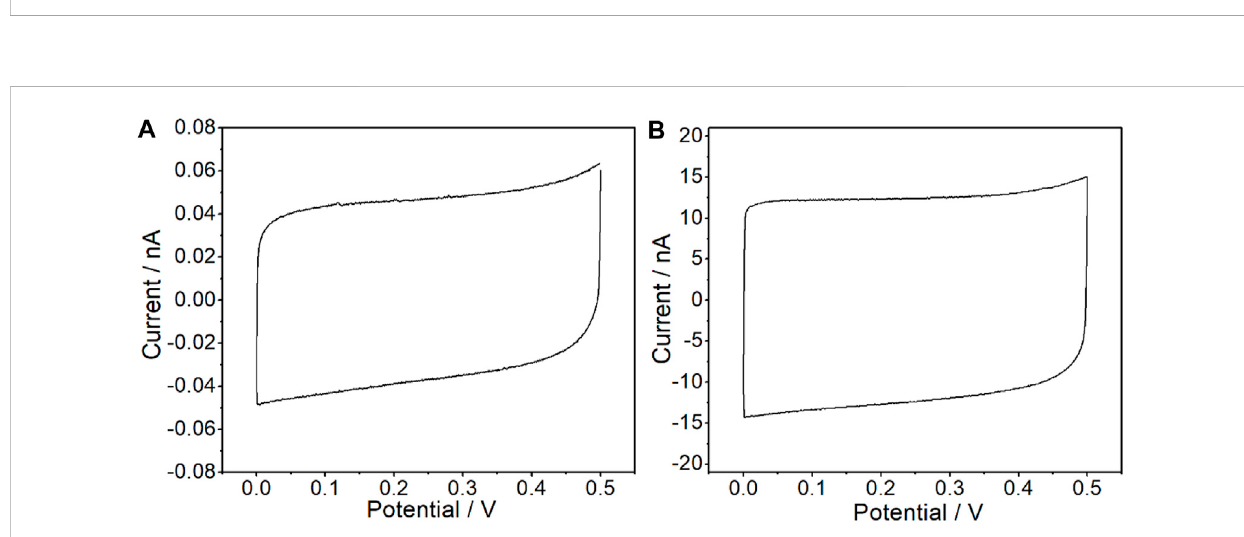
The impedance spectra of the CF μ E and CF μ E/PEDOT (PSS) both indicate fast charge transfers at the interfaces for the near-90 ° capacitive lines with the absence of the high-frequency semicircle (Figure 4A). According to the equation, C = − 1/(2 π fZ ″ ), where f is the lowest frequency used to record the spectra (0.01 Hz) and Z ″ is the impedance at this frequency (Zhou et al., 2010; Ocaña et al., 2018). The redox capacitance of the CF μ E and CF μ E/PEDOT (PSS) was calculated to be 1.6 ± 0.2 nF and 453.4 ± 9.7 nF, respectively. This phenomenon agrees well with the results obtained by CV, where CF μ E/PEDOT (PSS) shows much higher redox capacitance than the bare CF μ E. Therefore, serving as the ion-to-electron transducer of the all-solid-state Ca 2+ -IS μ E, the PEDOT (PSS) fi lm has suf fi ciently high bulk (redox) capacitance. The impedance spectra of the CF μ E/PEDOT (PSS)/Ca 2+ -ISE were also recorded in 0.1 M KCl solution (Figure 4B), and the bulk capacitance of the CF μ E/PEDOT (PSS)/Ca 2+ -ISE was calculated to be 256.3 ± 28.2 nF when fi tting the equivalent circuit (average error, χ 2 = 0.09), which is lower than that of the CF μ E/PEDOT (PSS) (458.7 ± 32.9 nF), and this phenomenon may be due to the coating of the calcium ion- selective